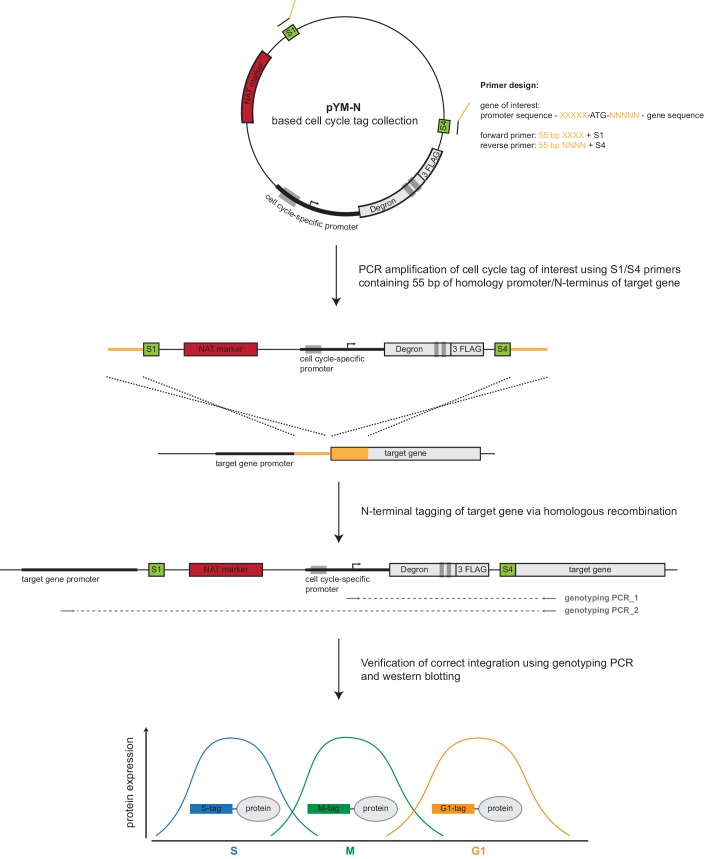
Schematic representation of the cell cycle tagging procedure.A construct from the pYM-N-based (Janke et al., 2004) collection of cell cycle tags is used as a template for PCR amplification and homologous recombination-based tagging of a gene of interest. A detailed description of the workflow can be found in Materials and methods (construction of cell cycle-tagged strains).